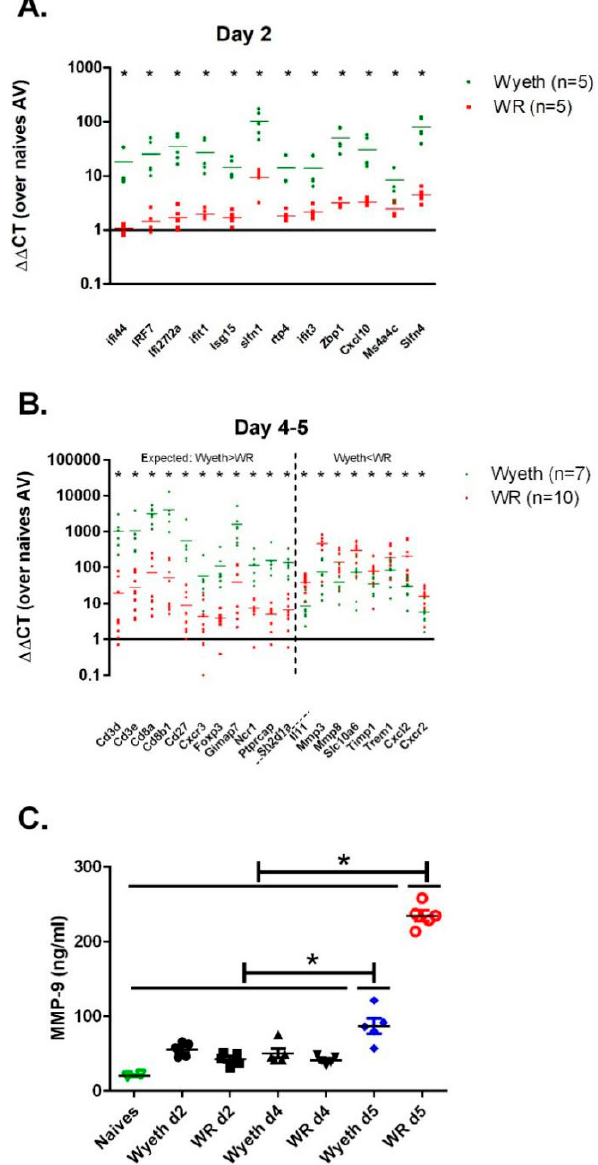
Figure 7. Verification of gene expression analysis. Expression of selected genes was measured by quantitative real-time RT-PCR on brain RNA isolated from mice infected i.c. with VACV-Wyeth (10 6 pfu) or VACV-WR (10 2 pfu) 2 ( A ) 4 or 5 d.p.i ( B ). Vertical dashed line in panel B, marks the border between the set of genes that were expected to be higher in the VACV-Wyeth compared to the VACV-WR, based on the whole genome RNA seq (left to the line) and the genes that were expected to be higher in the VACV-WR compared to VACV-Wyeth (right to the line). ( C ) MMP-9 protein levels in sera of naive mice, VACV-Wyeth and VACV-WR infected mice at 2, 4, and 5 d.p.i. Asterisks denote p < 0.05 ( t